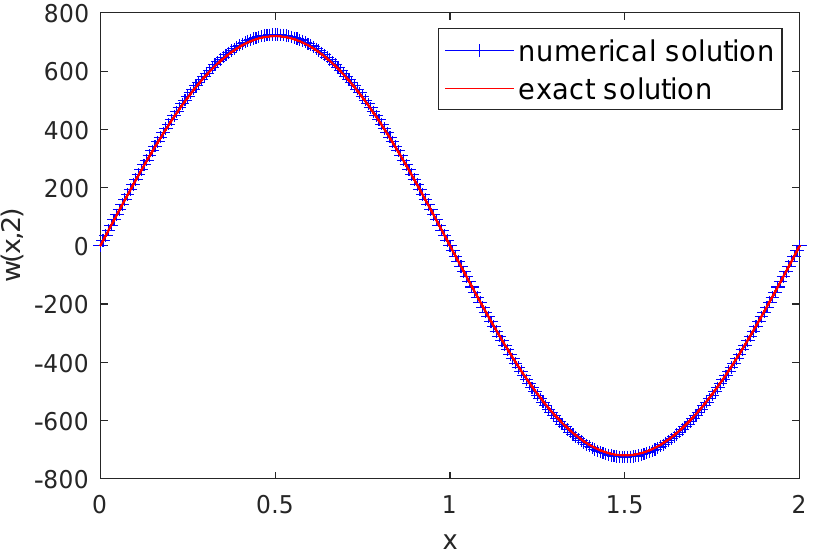
Figure 2. Graph of the bending moment at t = 2 when α = 1.3, T = 2, L = 2, M = N = 32. Figures 3 and 4 show the contour plots of the numerical solution and the exact solution of displacement, respectively, and Figures 5 and 6 show the contour plots of the numerical solution and the exact solution of bending moment, respectively. It can be seen from the figure that the numerical solution approximates the exact solution at different grid points, which proves the effectiveness of the MFVE method.